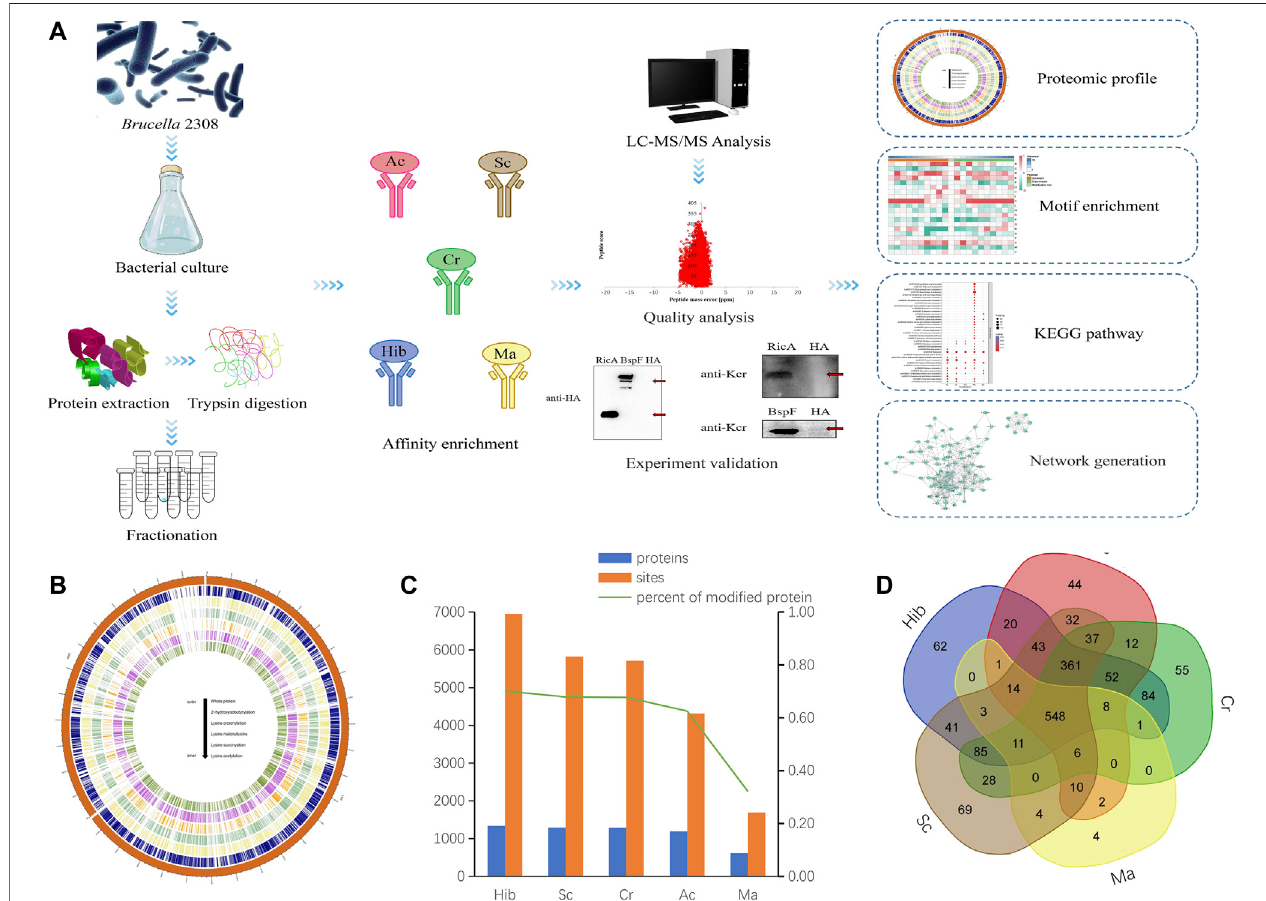
FIGURE 1 | Acylation Modi fi cations of B. abortus 2308. Flowchart of the proteomic procedures for protein and modi fi cation site identi fi cation (A). Circos plot showingtheabundancecon fi gurationsof fi vemodi fi cationomicsinchromosomedistribution (B) .Histogramsofproteomesand fi vePTM-omicsof B.abortus 2308.The number of identi fi ed proteins and modi fi cation sites are included. The number of modi fi ed proteins (blue), the number of modi fi cation sites (orange) (C) . Venn diagram showing overlap among fi ve lysine modi fi ed proteins in B. abortus 2308. Ellipses in blue, red, green, yellow and brown represent the numbers of proteins modi fi ed by lysine 2-hydroxyisobutyrylation, acetylation, crotonylation, malonyllysine and succinylation identi fi ed in B. abortus 2308, respectively. Overlap regions represent the number of proteins with all modi fi cations in B. abortus 2308 (D) .